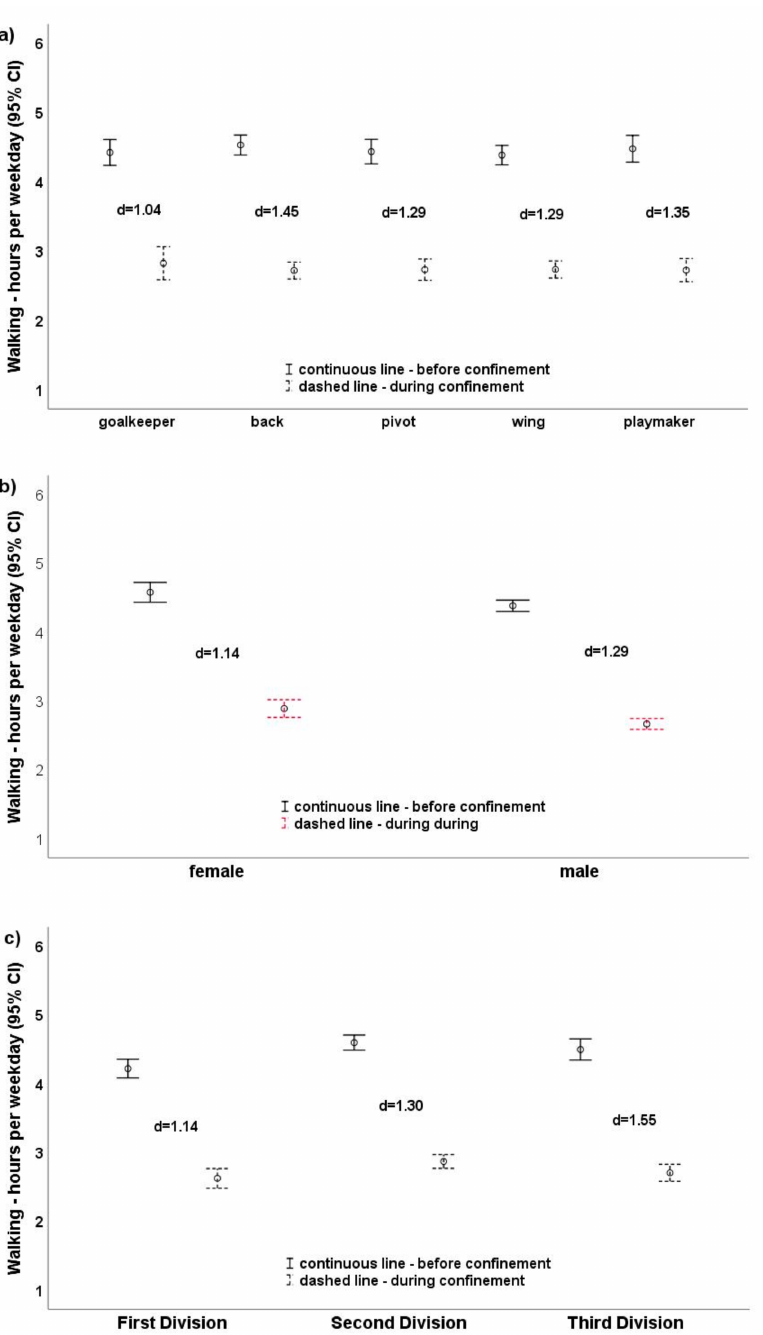
Figure 2. ( a – c ). Walking hours per weekday depending on playing positions ( a ), gender ( b ), and level of handball league ( c